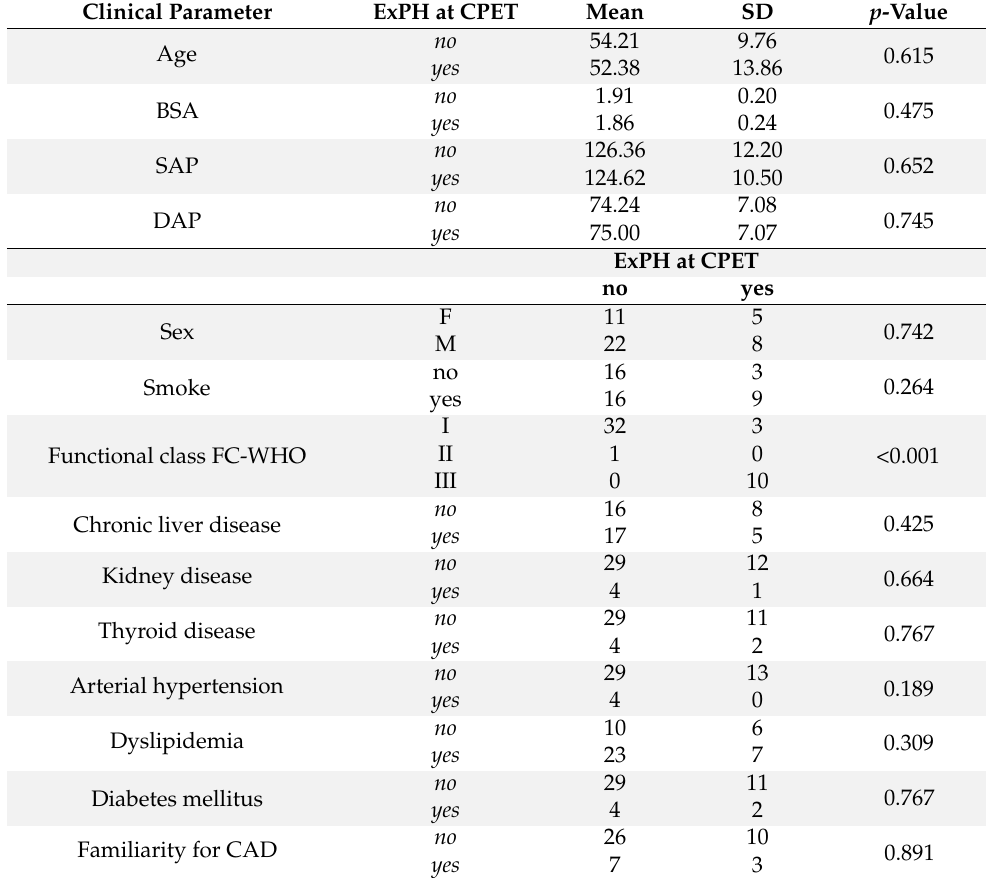
Table A1. Demographics, medical history and medication use according to presence and absence of ExPH at